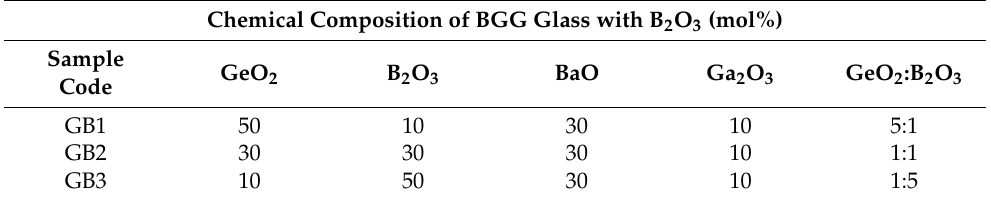
Table 2. Nominal composition (mol%) and GeO 2 /B 2 O 3 ratio of glass samples.